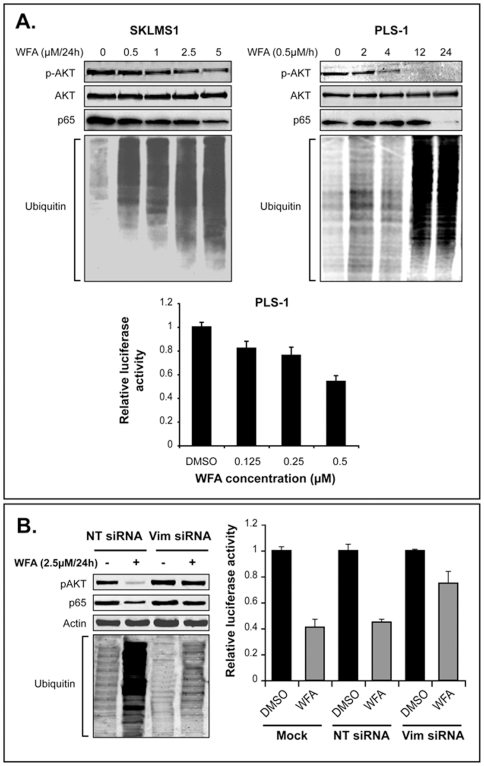
WFA-induced molecular deregulations are, at least partly, mediated by vimentin.
A) WFA treatment induces a dose- and time- dependent decrease in pAKT without effect on total AKT. Similarly, a dose-dependent decrease in NF-κB (p65) protein expression is also seen, although this decrease occurs only after 24 h of treatment. NF-κB activity in PLS1 cells, as depicted in graphs representing luciferase reporter assay results, is shown to be inhibited early after treatment (4 h). A marked dose- and time-dependent accumulation of ubiquitinated proteins is also shown; B) Vimentin knockdown in SKLMS1 cells abrogates WFA (2.5 µM/24 h)-induced pAKT inhibition, NF-κB protein decrease, and increased levels of protein ubiquitination. Similarly, vimentin knockdown blocks WFA (1 µM/4 h)-induced decrease in NF-κB activity. Graphs represent the average of three repeated experiments ±SD.